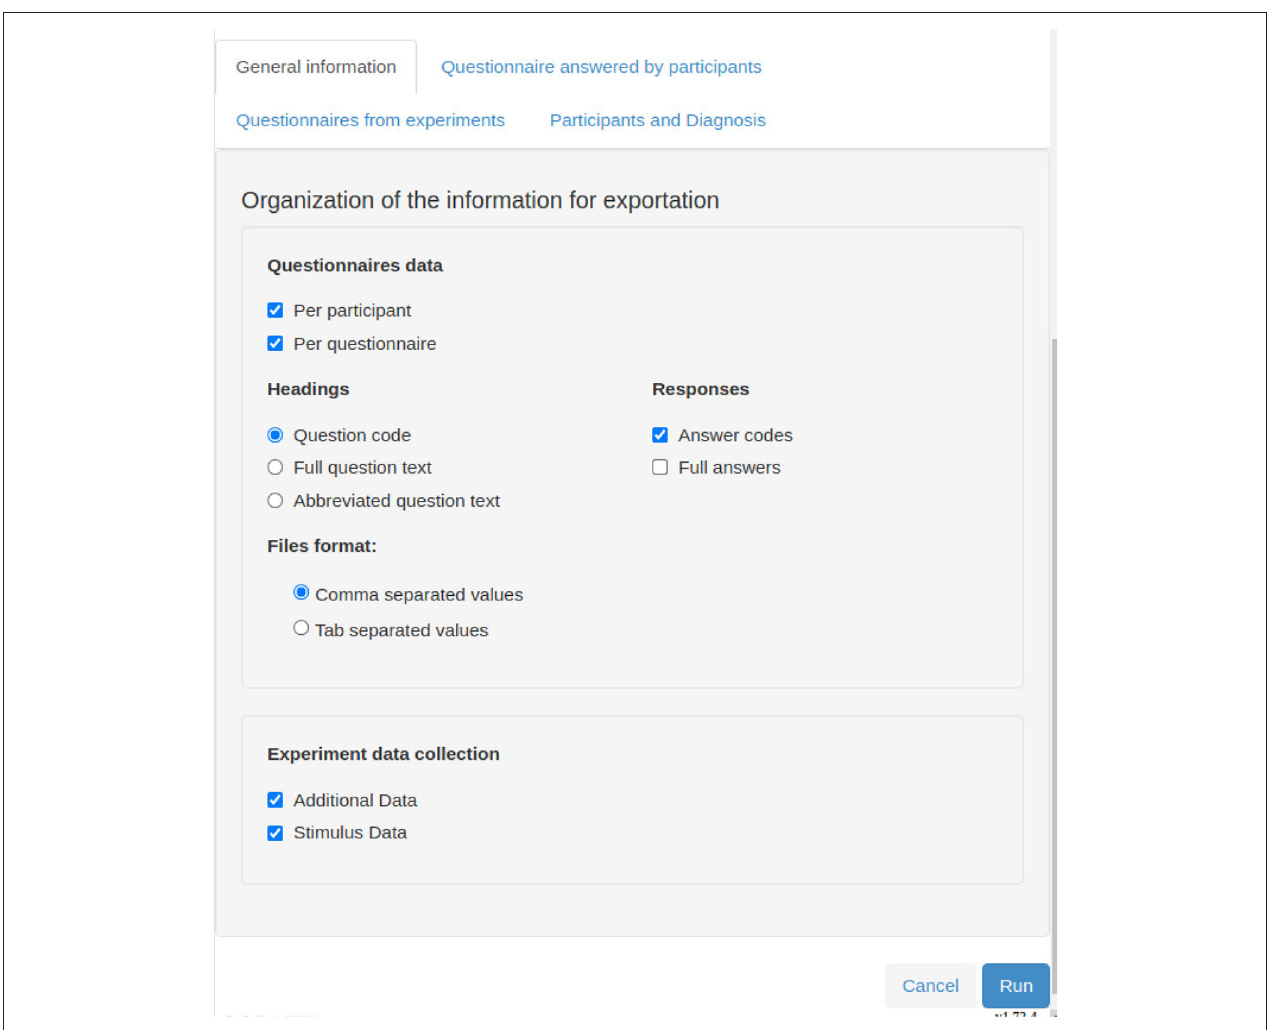
FIGURE 12 | NES graphical interface for selecting data export